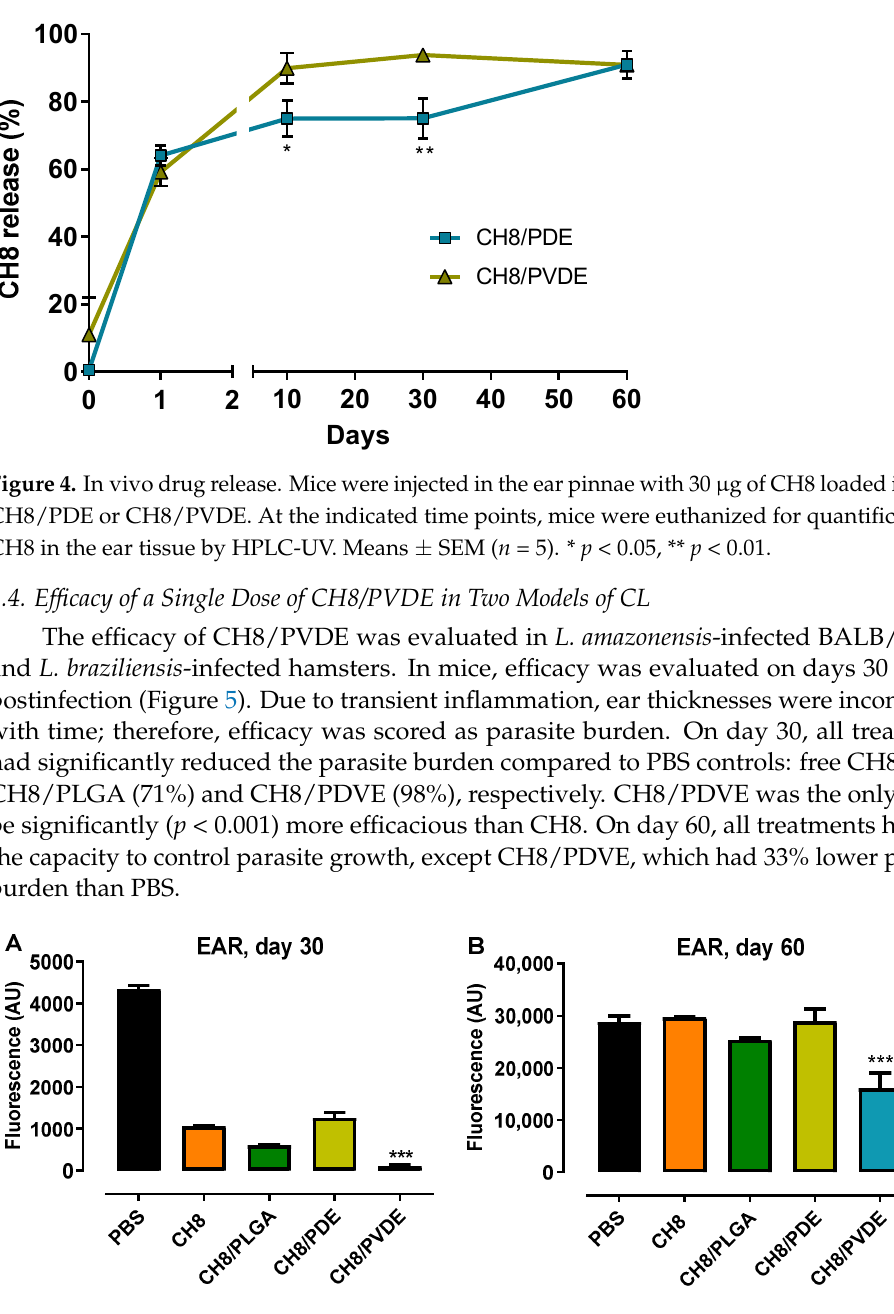
Figure 5. CH8/PVDE efficacy in L. amazonensis -infected mice. BALB/c mice were infected with 2 × 10 6 L. amazonensis - GFP promastigotes in the ear pinnae and treated 7 days later with a single intralesional injection of CH8 (30 µ g/dose—1.3 mg/kg body weight) in the free form or encapsulated in the indicated MPs. Controls received 10 µ L of PBS alone. On days 30 and 60 posttreatment, mice were euthanized, and the parasite loads quantified by fluorimetry discounting the basal value of fluorescence of contralateral uninfected ears. A.U. = arbitrary units. Means ± SEM ( n = 5) *** p < 0.001 against all